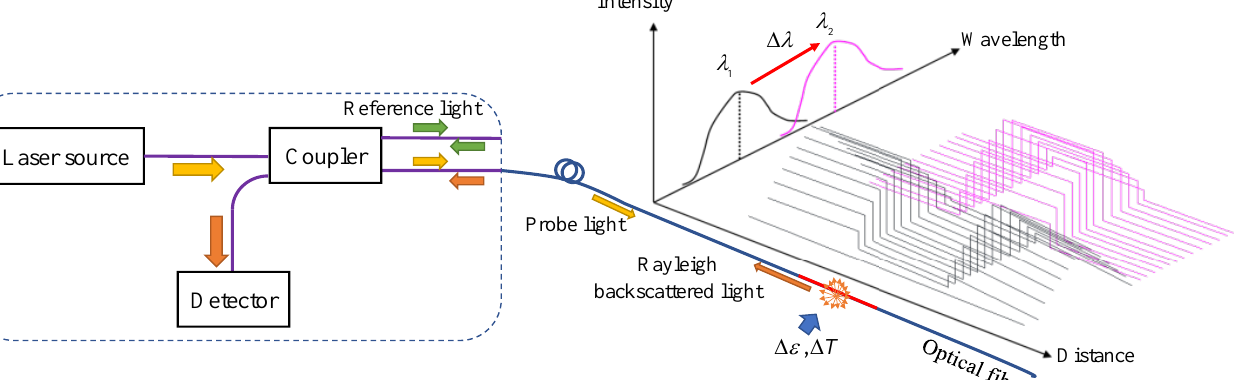
Figure 1. Measuring principle of OFDR technology. Table 2. Specification of OFDR interrogator and optical